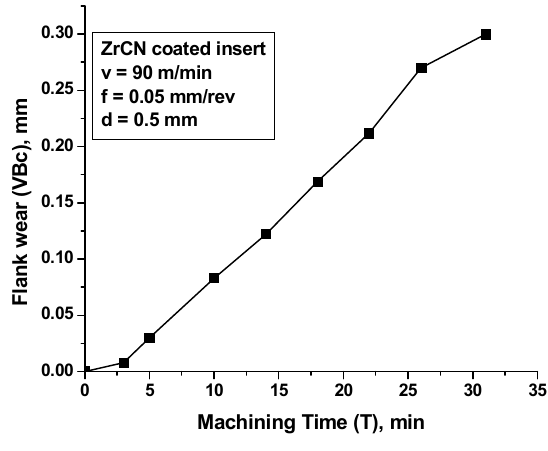
Fig. 1. Progressions of flank wear with machining time